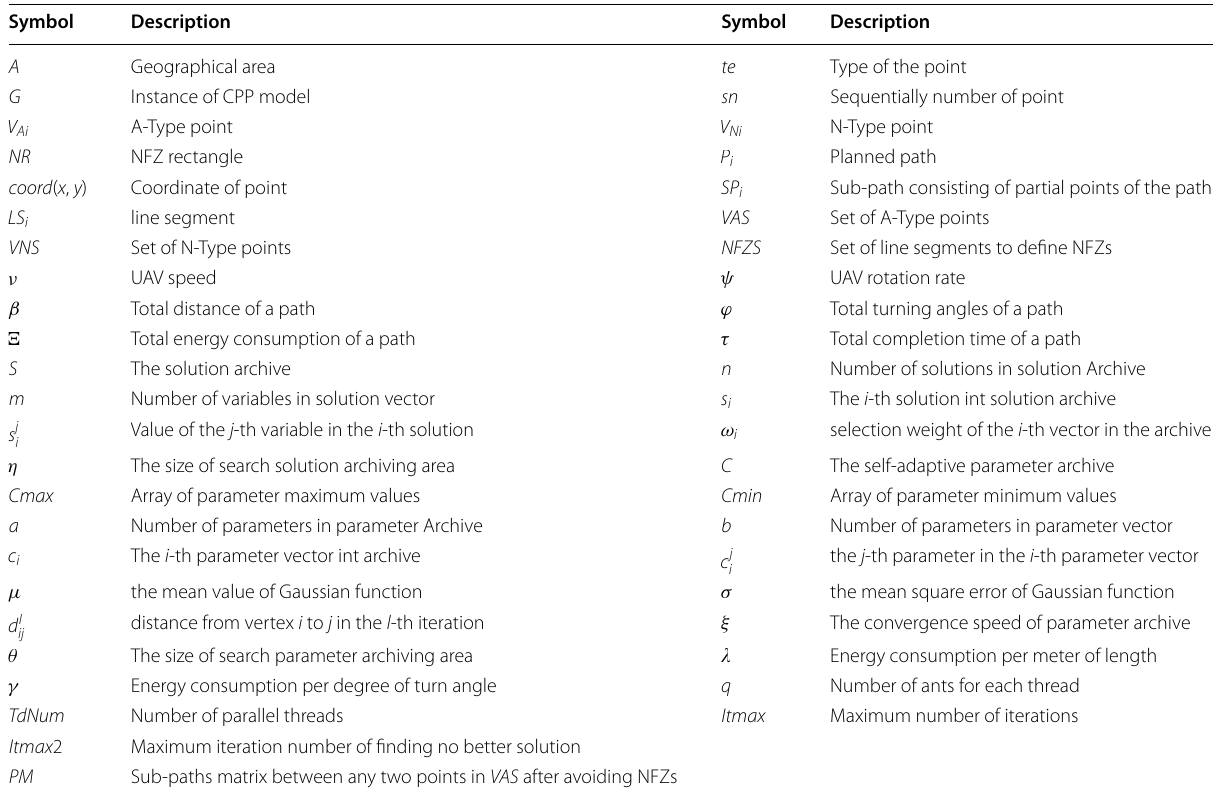
Table 1 Table of